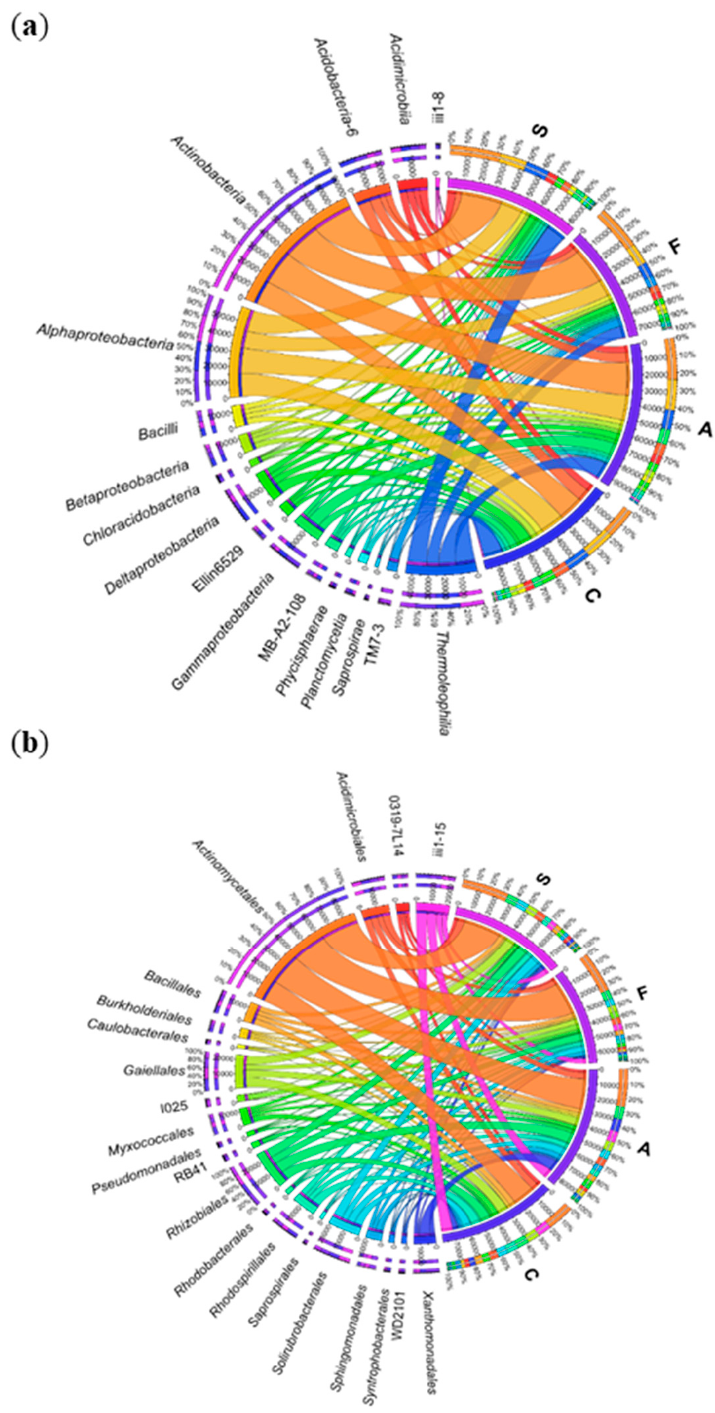
Figure 7. The relative abundance of dominant classes ( a ) and orders ( b ) of bacteria in soil with a di ff erence between proportions ≥ 1%. C—uncontaminated soil; A—soil contaminated with BPA; F—soil contaminated with BPF; S—soil contaminated with BPS.